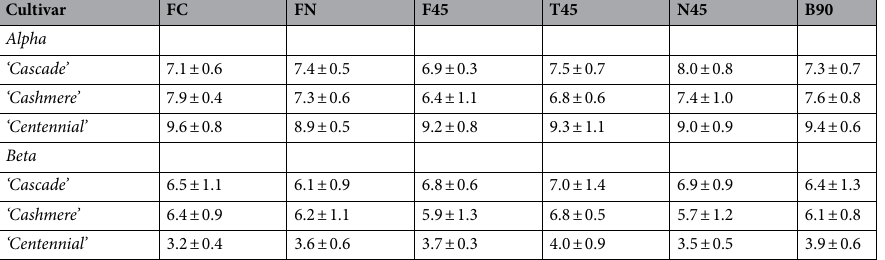
Table 3. Observed alpha and beta-bitter acids of hop cultivars across treatments. Control free to climb at 90° (FC), free to climb a strand of 90° netting (FN), free to climb twine at 45° slope (F45), touch on twine at 45° slope (T45), touch on a single strand of trellis netting at 45° slope (N45), and 6) 90° internode bending on netting at a 45° mean slope (B90). Observed means of n = 4 100 g cone subsamples per cultivar per treatment ± standard deviation. Acid values are cone dry weight percentages. Alpha and beta-bitter acids means among treatments were not statistically different from each other ( P >